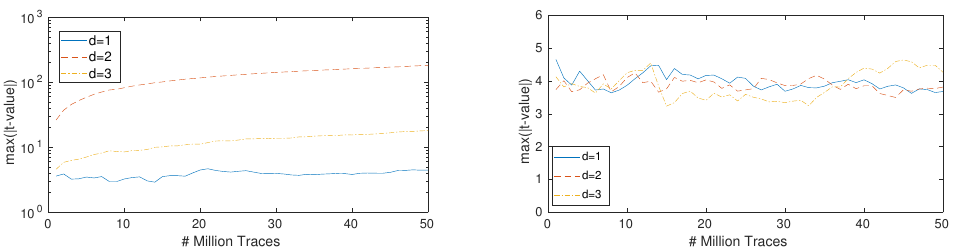
Figure 10: Evolution of the maximum absolute t-value across the measurements. Left: First order. Right: Second order.